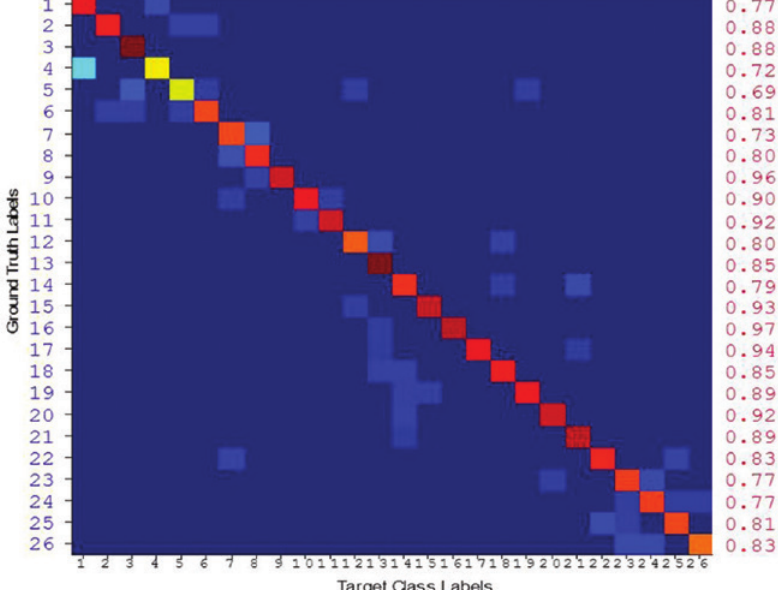
Figure 5: Confusion Matrix Obtained for (50:50) Training and Testing